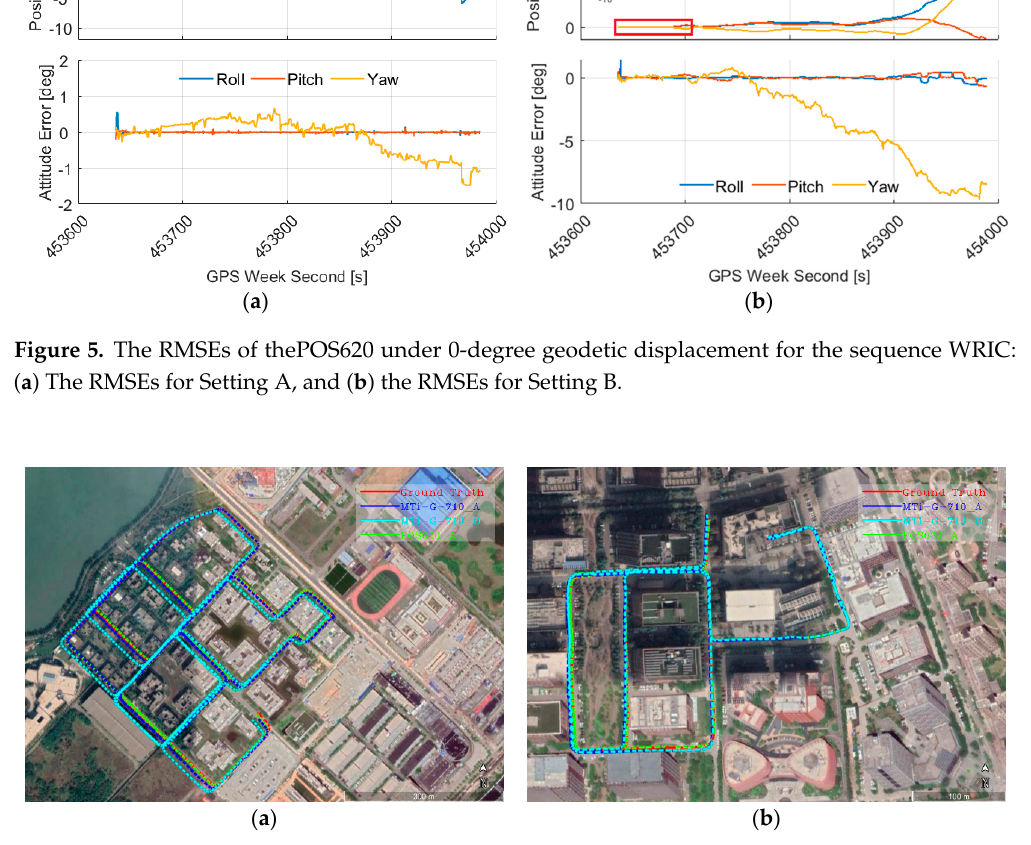
( a ) ( b ) Figure 8. The RMSEs of the MTi-G-710 under 0.5-degree geodetic displacement for the sequence WRIC: ( a ) The RMSEs for Setting A, and ( b ) the RMSEs for Setting C. ( a ) ( b ) Figure 9. The RMSEs of the MTi-G-710 under 1.0-degree geodetic displacement for the sequence WRIC: ( a ) The RMSEs for Setting A, and ( b ) the RMSEs for Setting C.